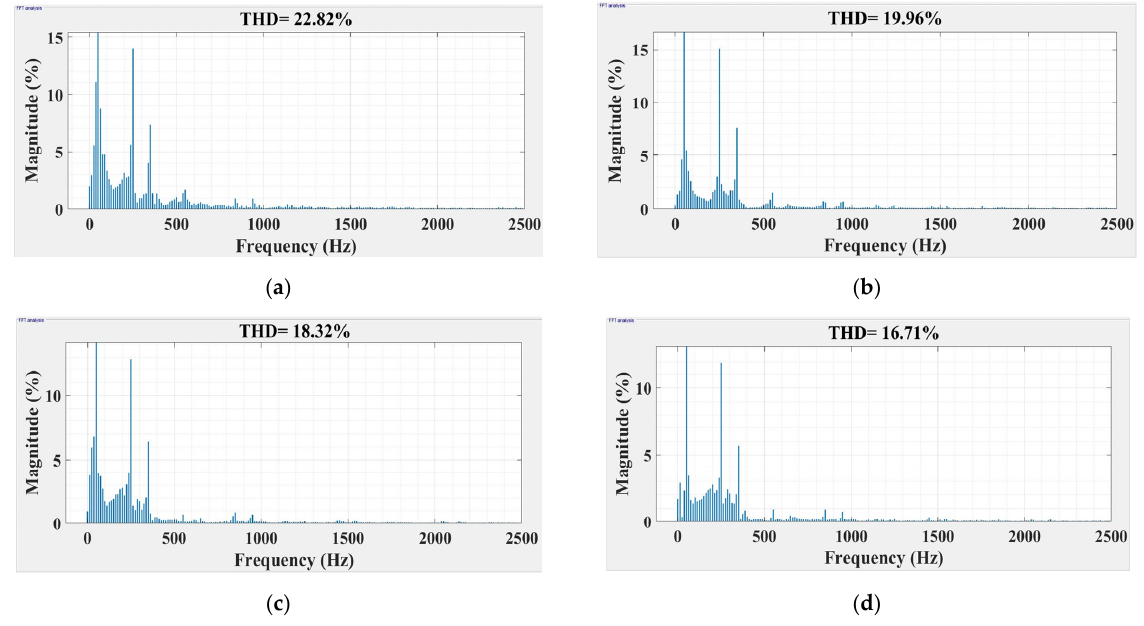
Figure 16. FFT analysis and THD current calculus for APF control: ( a ) PI controller and nonlinear load; ( b ) PI controller and linear load; ( c ) PI controller with RL-TD3 agent and nonlinear load; ( d ) PI controller with RL-TD3 agent and linear load.